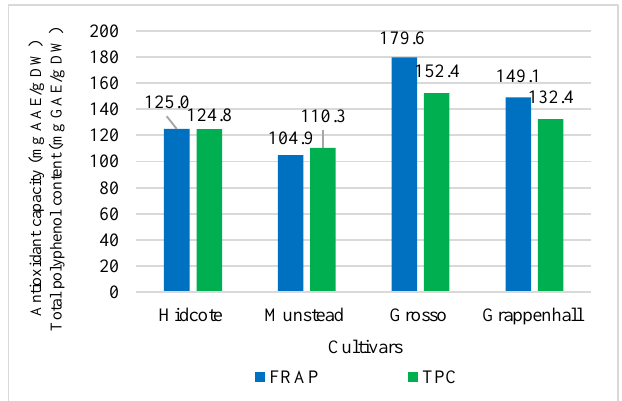
Figure 1. Antioxidant capacity (FRAP: mg AAE/g DW) and total polyphenol content (TPC: mg GAE/g DW) values of L. angustifolia and L. × intermedia cultivars in Dörgicse